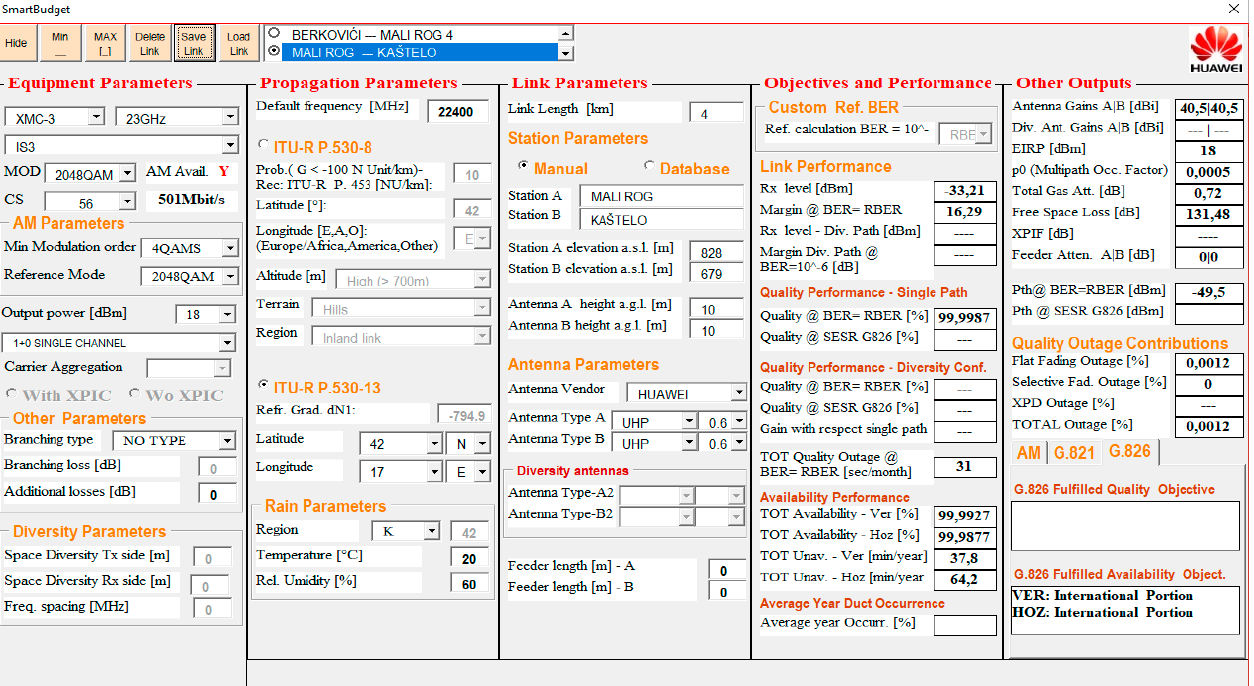
Electronics 2021 , 10 , x FOR PEER REVIEW 10 of 21